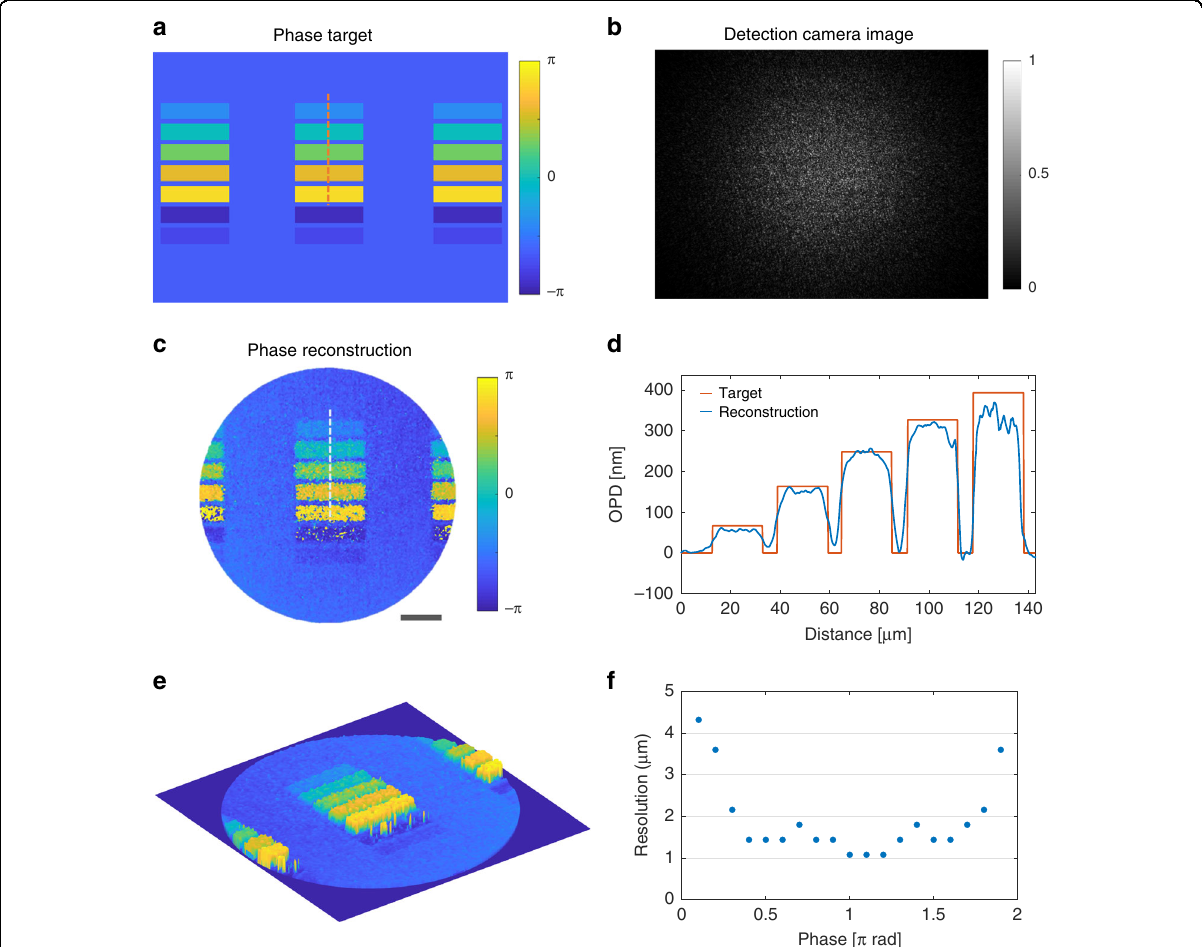
Fig. 4 Quantitative phase imaging through the microendoscope via far- fi eld speckle reconstruction. a The phase target is imaged on the distal side of the microendoscope. b The far- fi eld speckle image of the phase target is captured on the camera. c Reconstructed phase image of the target from the speckle image. Scale bar 50 μ m. d Quantitative optical path difference pro fi le of the marked areas in ( a , c ). e 3D optical path difference map. f The measured lateral resolution of the system for different phase values. The measurement process is demonstrated in the Supplementary